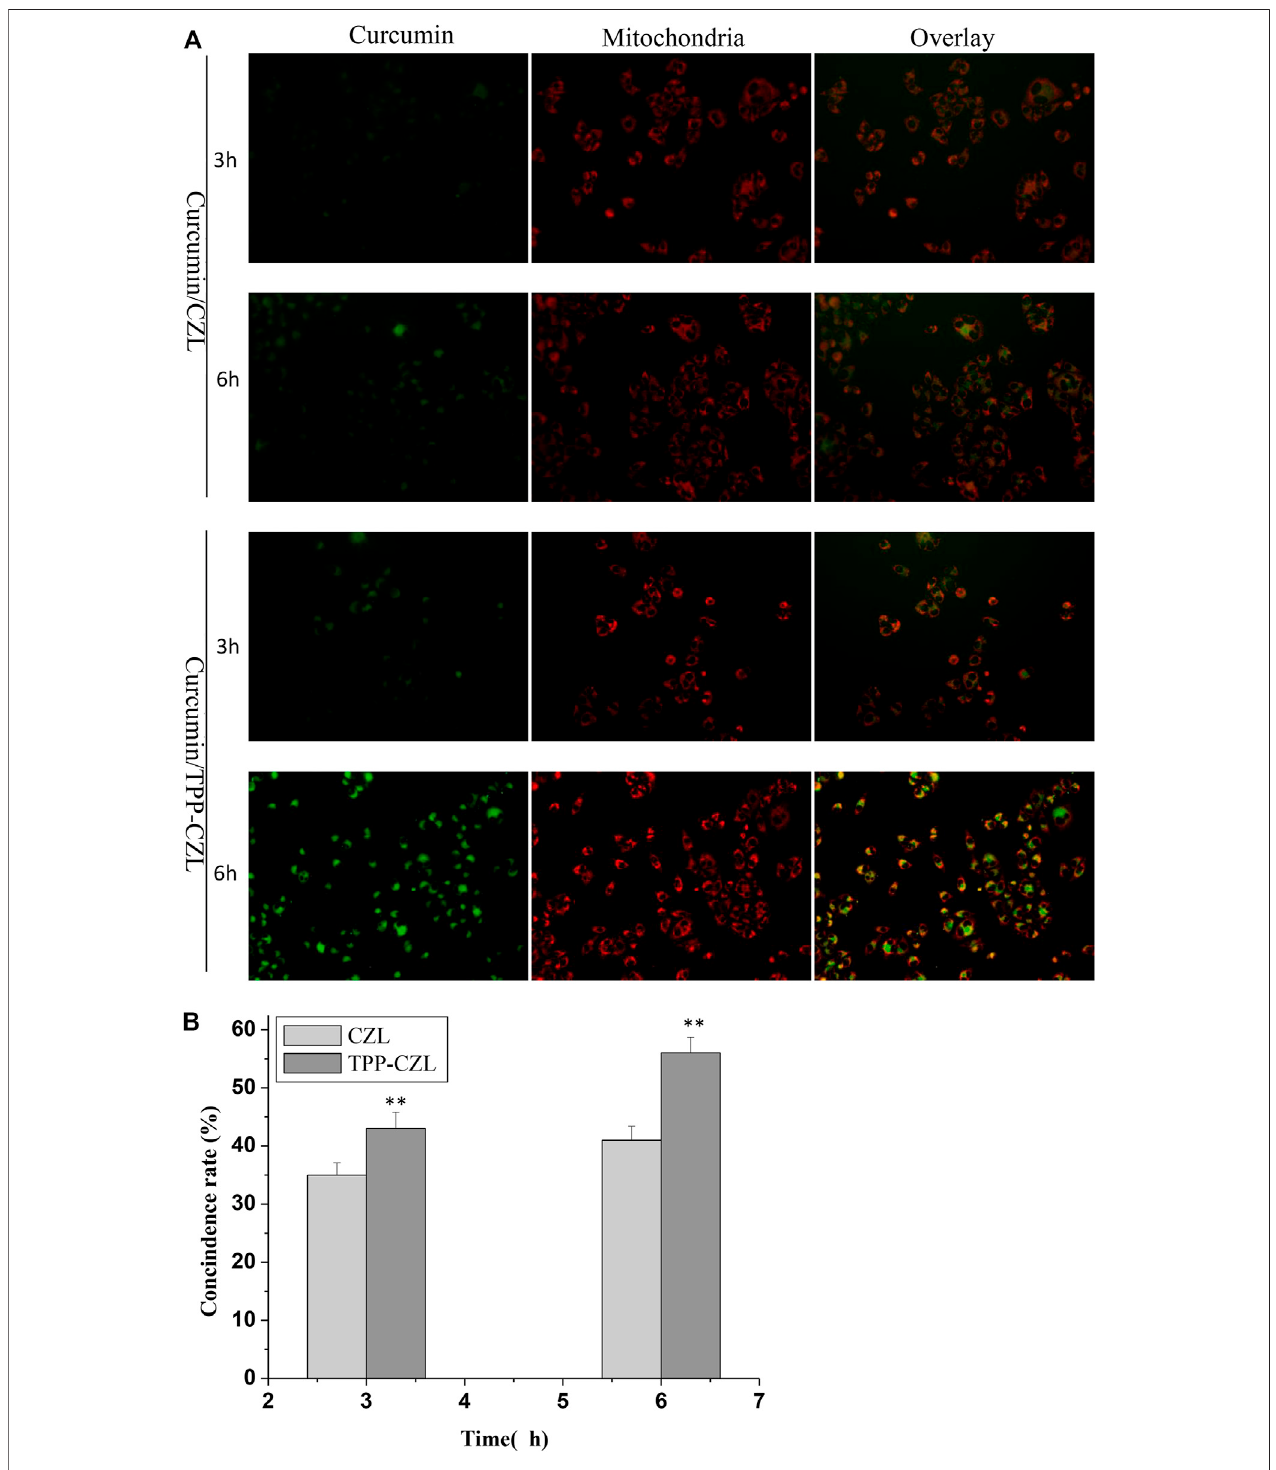
FIGURE 4 | Mitochondrial targeting of CZL and TPP-CZL. * p < 0.05, ** p < 0.01, *** p < 0.001 compared with CZL group.